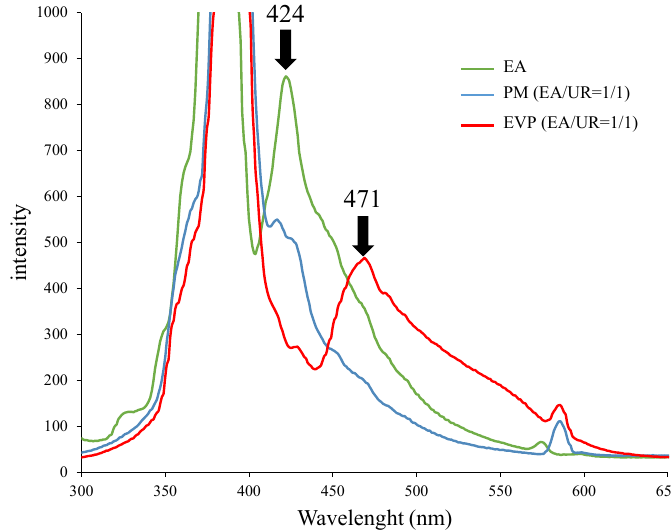
Figure 6. Fluorescence spectra of EA/UR systems.